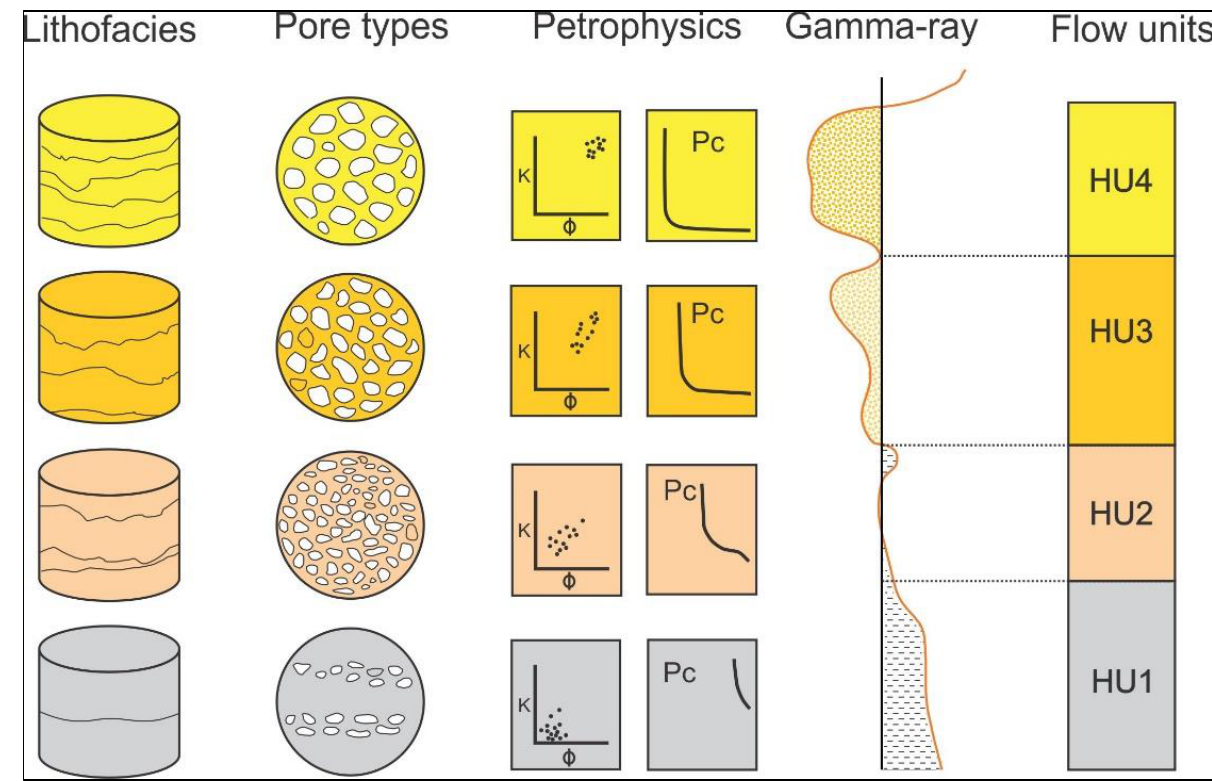
Figure 2. The hydraulic flow units are defined based on lithofacies, reservoir properties and GR log response (modified after Ebanks et al., 1992) [30].